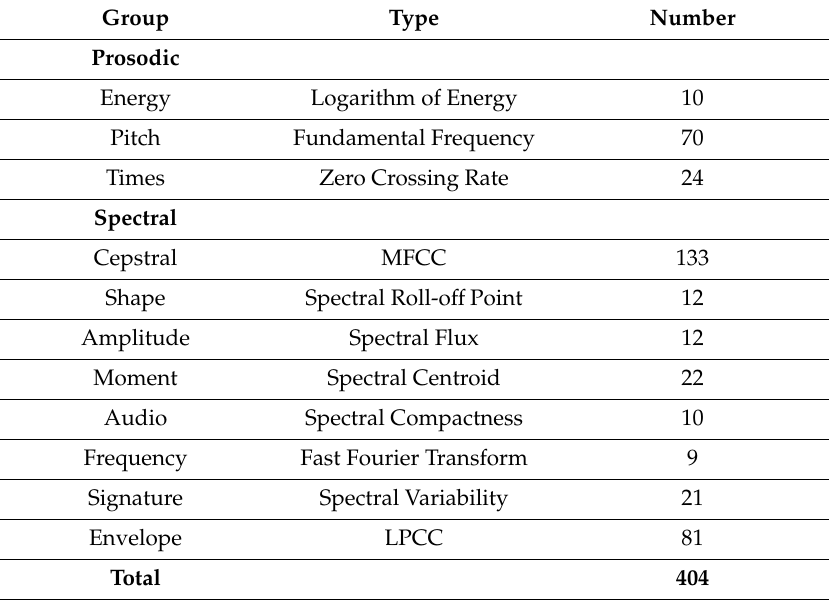
Table 2. List of the selected prosodic and spectral